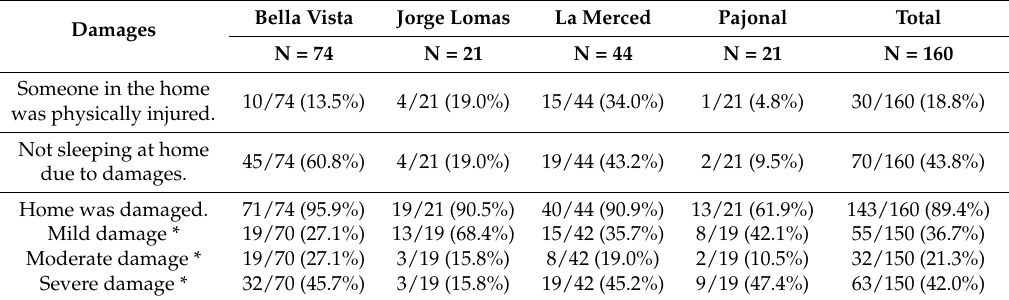
Table 2. Earthquake damages. Households (n and %) that reported that someone was injured, whether household members were sleeping at home, and damages to the home as a result of the earthquake. Bella Vista Jorge Lomas La Merced Pajonal Total Damages N = 74 N = 21 N = 44 N = 21 N = 160 Someone in the home 10/74 (13.5%) 4/21 (19.0%) 15/44 (34.0%) 1/21 (4.8%) 30/160 (18.8%) was physically injured. Not sleeping at home due to